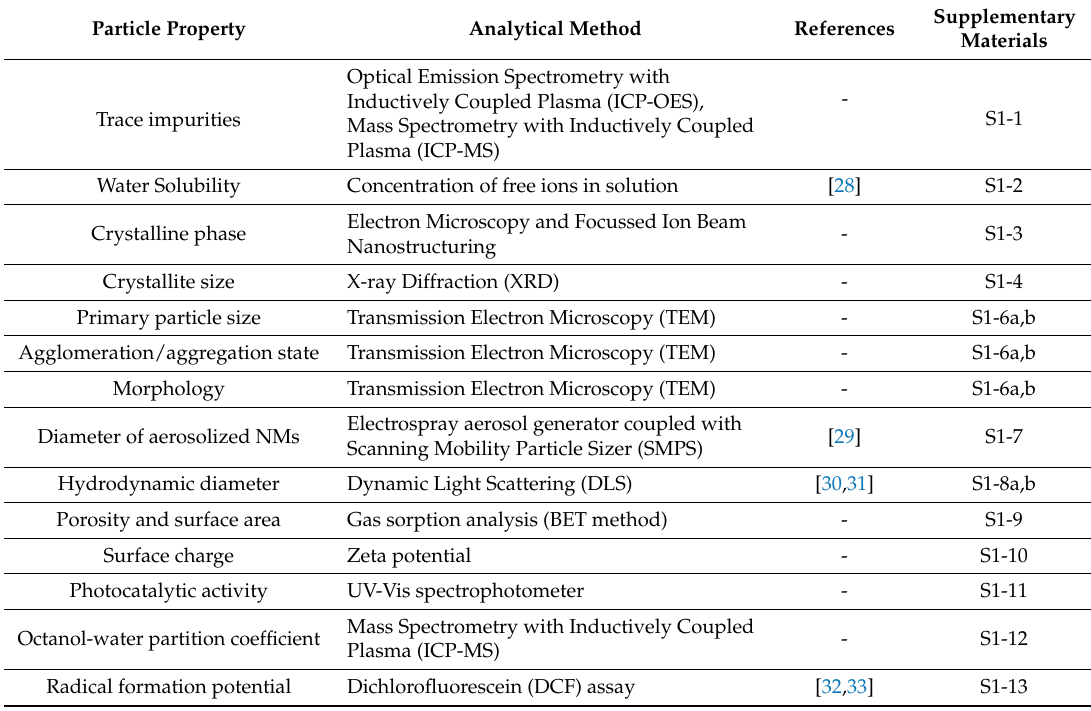
Table 1. Analytical methods chosen to characterize the particle